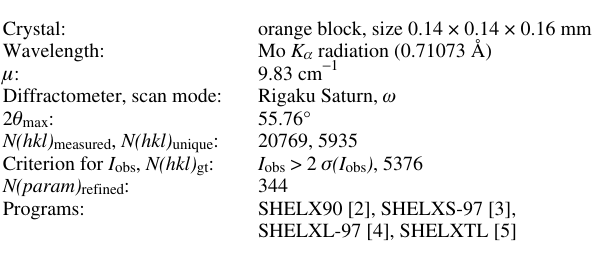
Table 1. Data collection and handling.